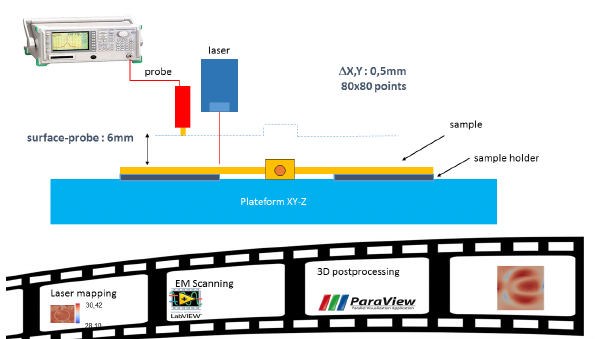
Figure 2: Experimental sequence of the microwave imager.